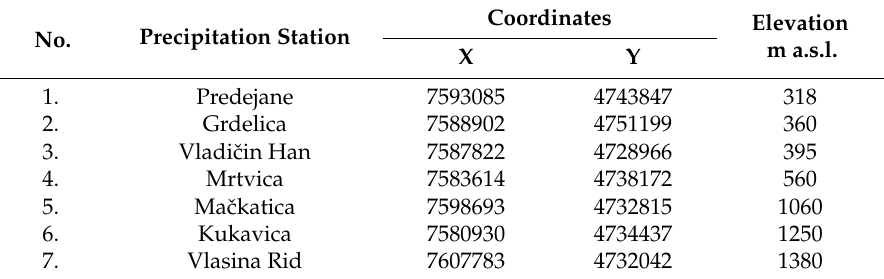
Table 1. Precipitation stations in the study